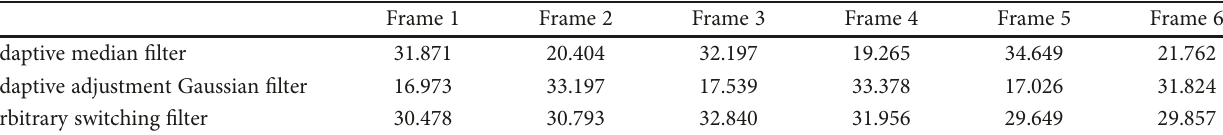
Table 2: Peak signal-to-noise ratio for each image after the second test. p = 25% and δ = 25 .